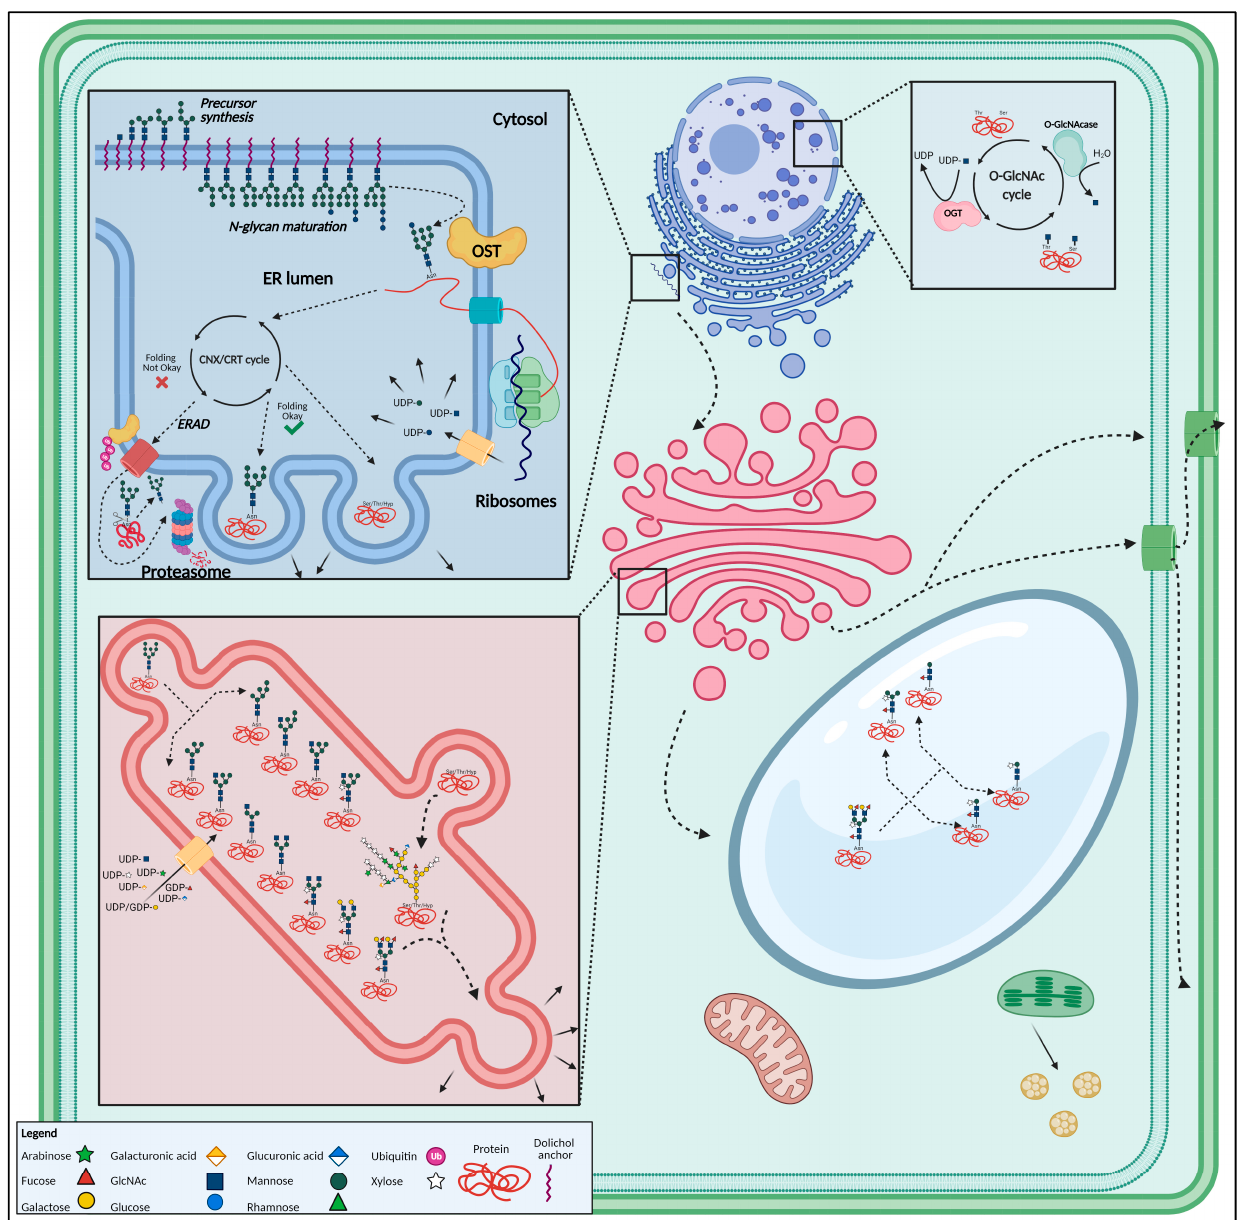
Figure 2. Overview of the most important glycosylated structures in the plant cell. N-glycan synthesis initiates in the endoplasmic reticulum, after which the glycan is added onto a polypeptide. Well-folded proteins are then guided towards the Golgi apparatus through vesicular transport, where the glycan structure is modified. After glycan maturation in the Golgi, glycoproteins are transported towards the vacuole, plasma membrane, cell wall or secreted. O-glycosylation occurs mainly in the Golgi apparatus. The O-GlcNAc modification takes place in the nucleus and cytoplasm. This figure was created with BioRender.com.